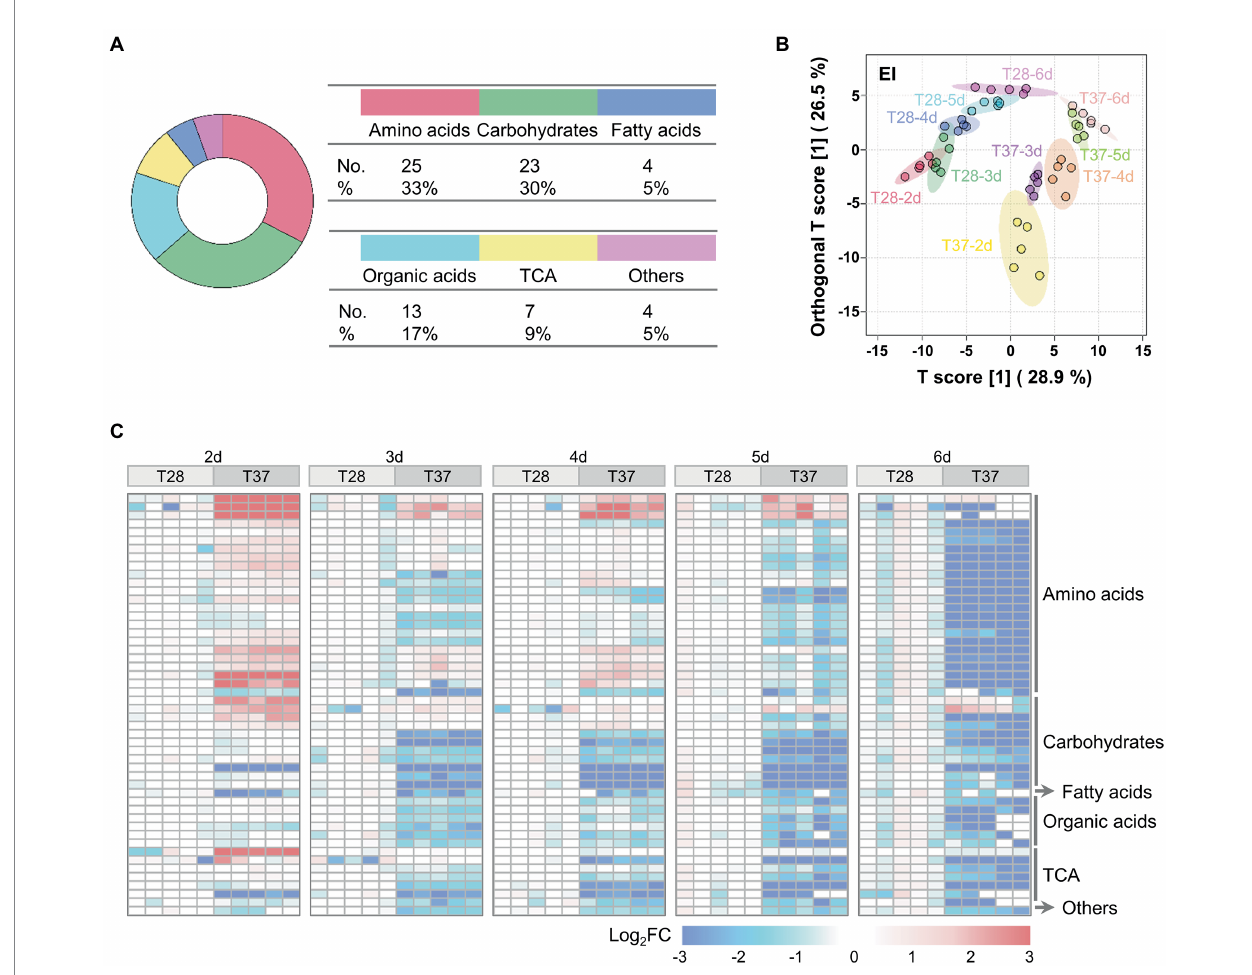
FIGURE 2 Multivariate statistical analysis of metabolomic data from A. flavus . (A) The classification and proportion of identified metabolites in A. flavus were obtained using GC–MS. (B) OPLS-DA score plots of GC–MS data for the T28 and T37 mycelia samples collected on the 2 nd to 6 th days. (C) Heat map showing Log 2 FC values for 50 metabolites differentially accumulated between T28 and T37 mycelia samples growth from the 2 nd to 6 th days. The relative abundance of each metabolite was normalized to the mean value from the T28 samples on different